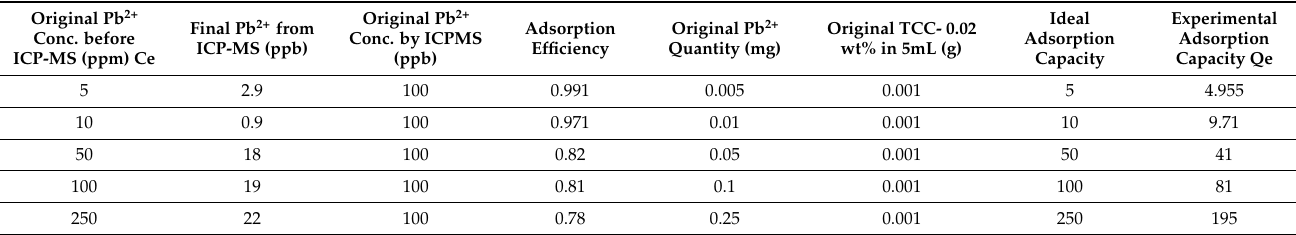
Table 1. Calculated Ideal Adsorption Capacity and Experimental Adsorption Capacity Against Pb 2+ Ions by TCC. Original Pb 2+ Conc. before